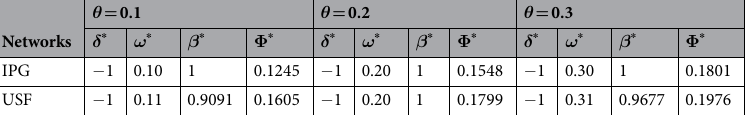
Table 1. The optimal disturbance strategies in two real-world critical infrastructure networks. IPG represents the India power grid and USF represents the U.S. fiber